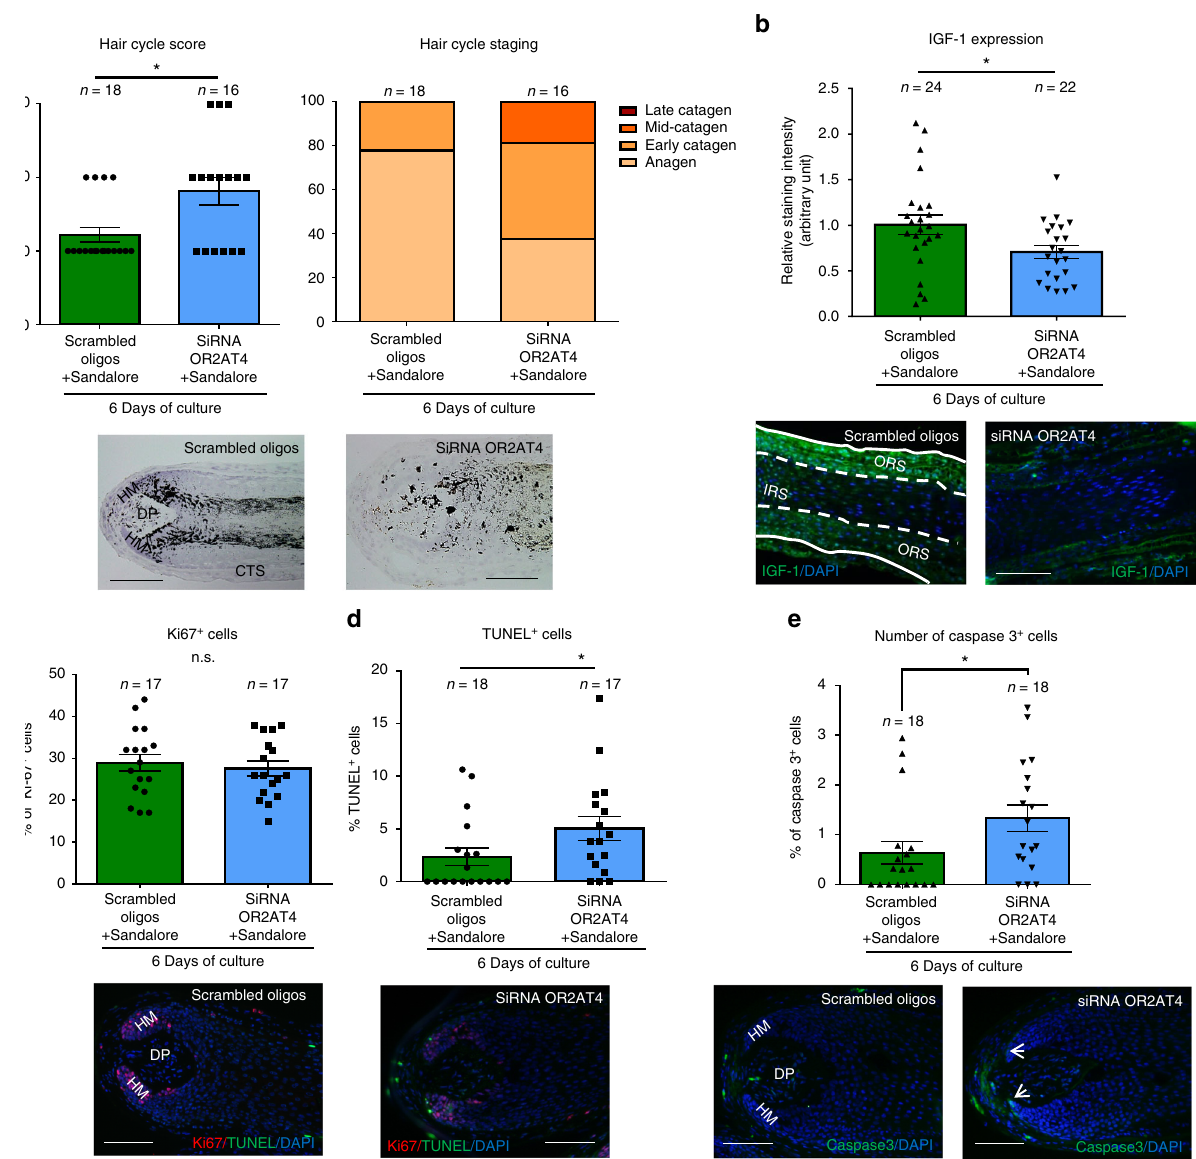
Fig. 5 The anagen prolongation effect of Sandalore ® is OR2AT4 dependent. a Hair follicle cycle score and staging were performed in HFs treated with siRNA OR2AT4 or scrambled oligos in the presence of Sandalore ® 32 . Representative images of vehicle and treated HFs after 6 days of treatment. Mean ± SEM, n = 16 – 18 HFs from three donors (independent experiments), Mann – Whitney test, * P < 0.05. b IGF-1 expression was quanti fi ed in ORS keratinocytes in treated and vehicle HFs using ImageJ. Representative pictures of IGF-1 immuno fl uorescence. Mean ± SEM, n = 22 – 24 HFs from three donors (independent experiments), Mann – Whitney test, * P < 0.05. c , d Ki67 + cells and TUNEL + cells were counted in the hair matrix of siRNA and control HFs. Representative pictures of Ki67/TUNEL double-staining in the hair bulb of HFs. Mean ± SEM, n = 17 – 18 HFs from three donors (independent experiments), Mann – Whitney test, * P < 0.05, n.s. not signi fi cant. e The number of cleaved caspase-3 + cells (white arrows) in the hair matrix was evaluated in the hair bulb of all HFs treated with OR2AT4-siRNA or scrambled oligos. Representative pictures of cleaved caspase-3 staining. Mean ± SEM, n = 18 HFs from